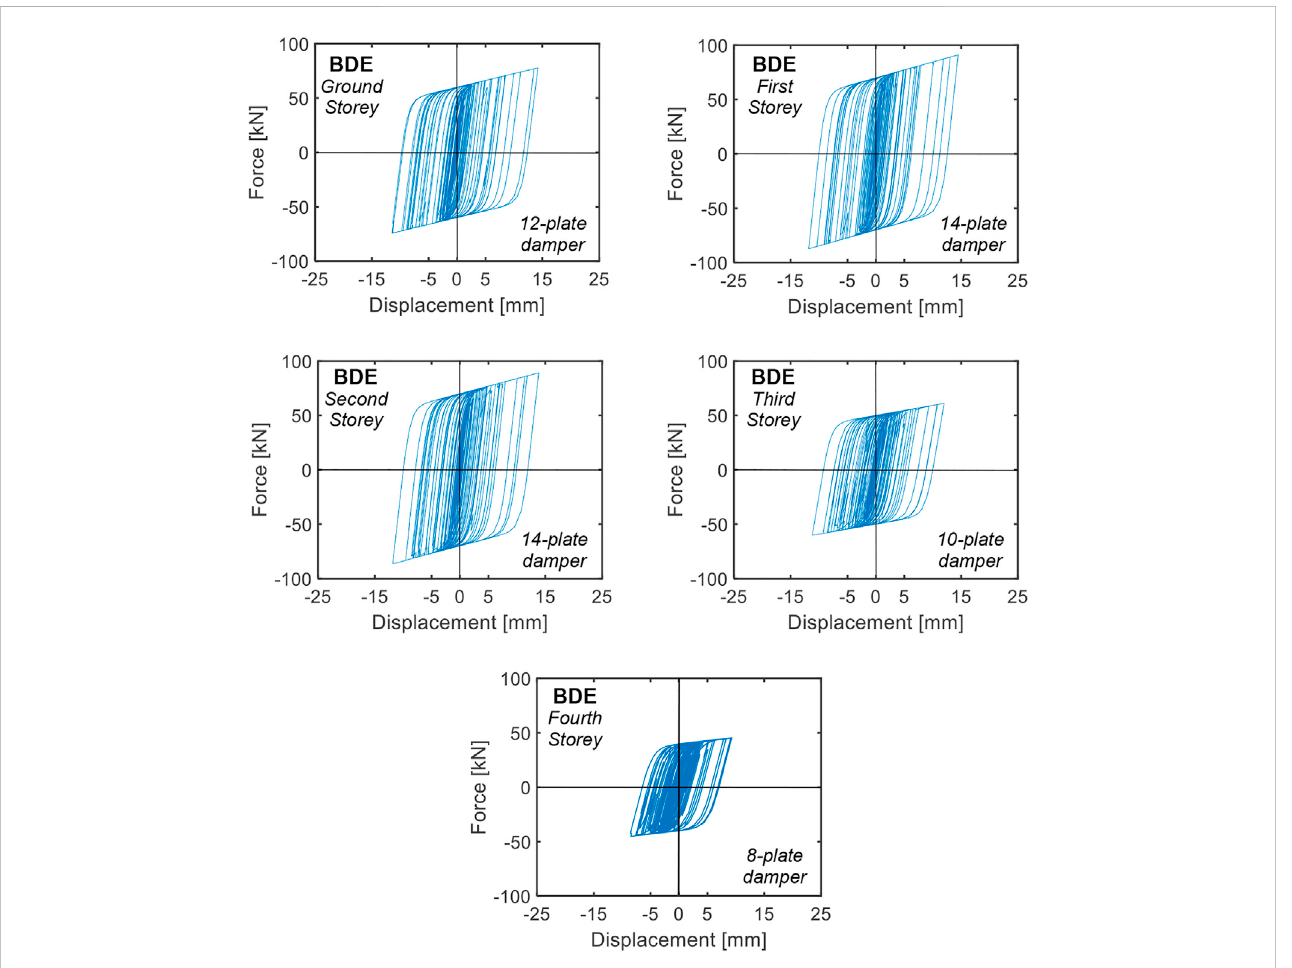
FIGURE 11 Response cycles of the dampers installed in the 2/D-3/D alignment obtained from the most demanding BDE-scaled group of input accelerograms.